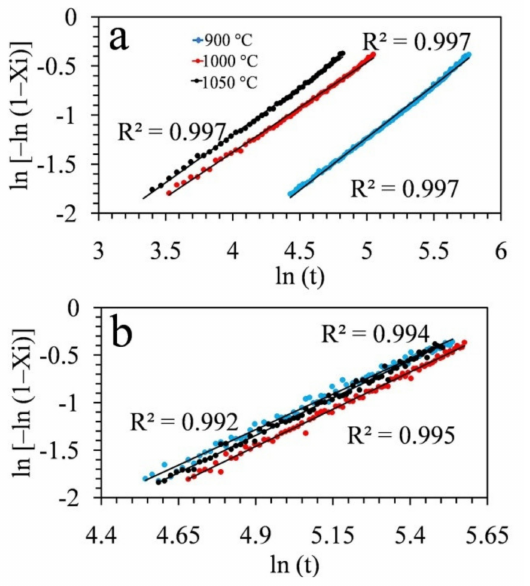
Figure 5. Hancock and Sharp plots for experimental solid-state conversion data at selected tempera- tures during ( a ) reduction and ( b )